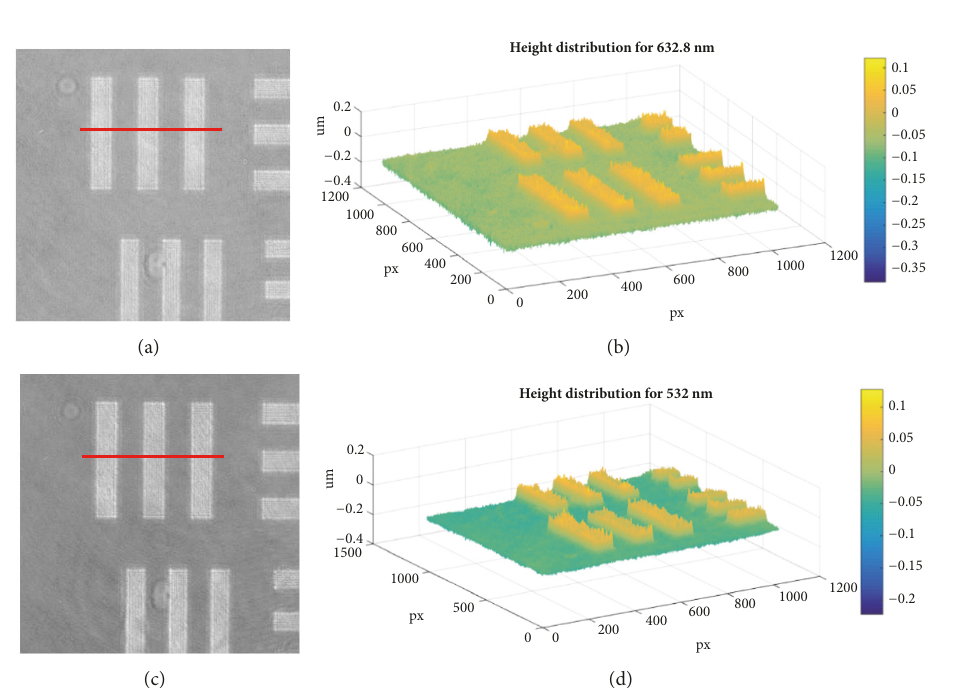
Figure 5: Experimental results with single wavelength measurement. (a) Phase image for 632.8 𝑛𝑚 , (b) height distribution for 632.8 𝑛𝑚 , (c) phase image for 532 𝑛𝑚 , and (d) height distribution for 532 𝑛𝑚 .